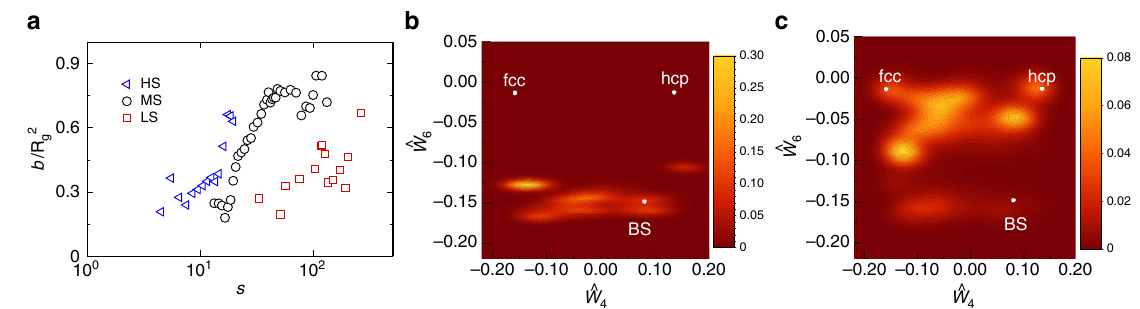
Figure 4 | Cluster morphology and local order. ( a ) Asphericity parameter, computed from the gyration tensor of the clusters, as a function of the cluster size at f ¼ 0.052 and T ¼ 0.15 for HS, MS and LS. ( b ) Heat maps of ( ^ w 6 , ^ w 4 ) values at f ¼ 0.079 and T ¼ 0.15 for HS and LS ( c ).